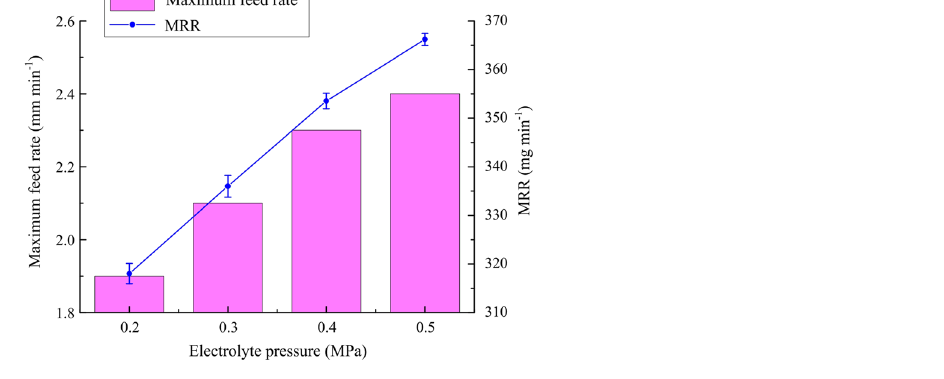
Figure 12. Variations of maximum feed rate and MRR with electrolyte